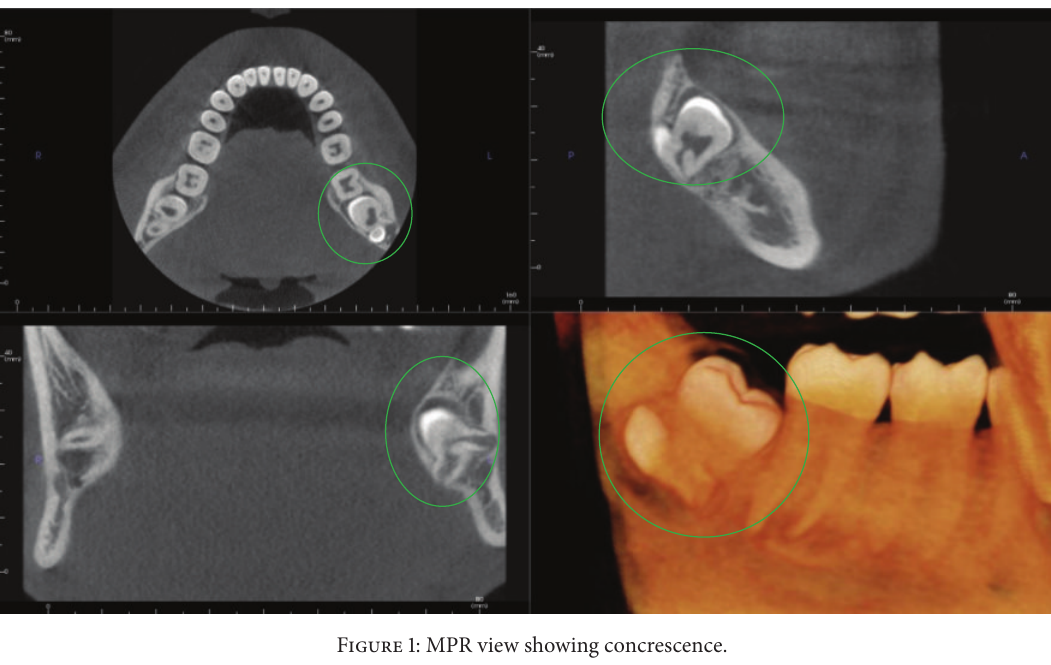
Figure 1: MPR view showing concrescence.